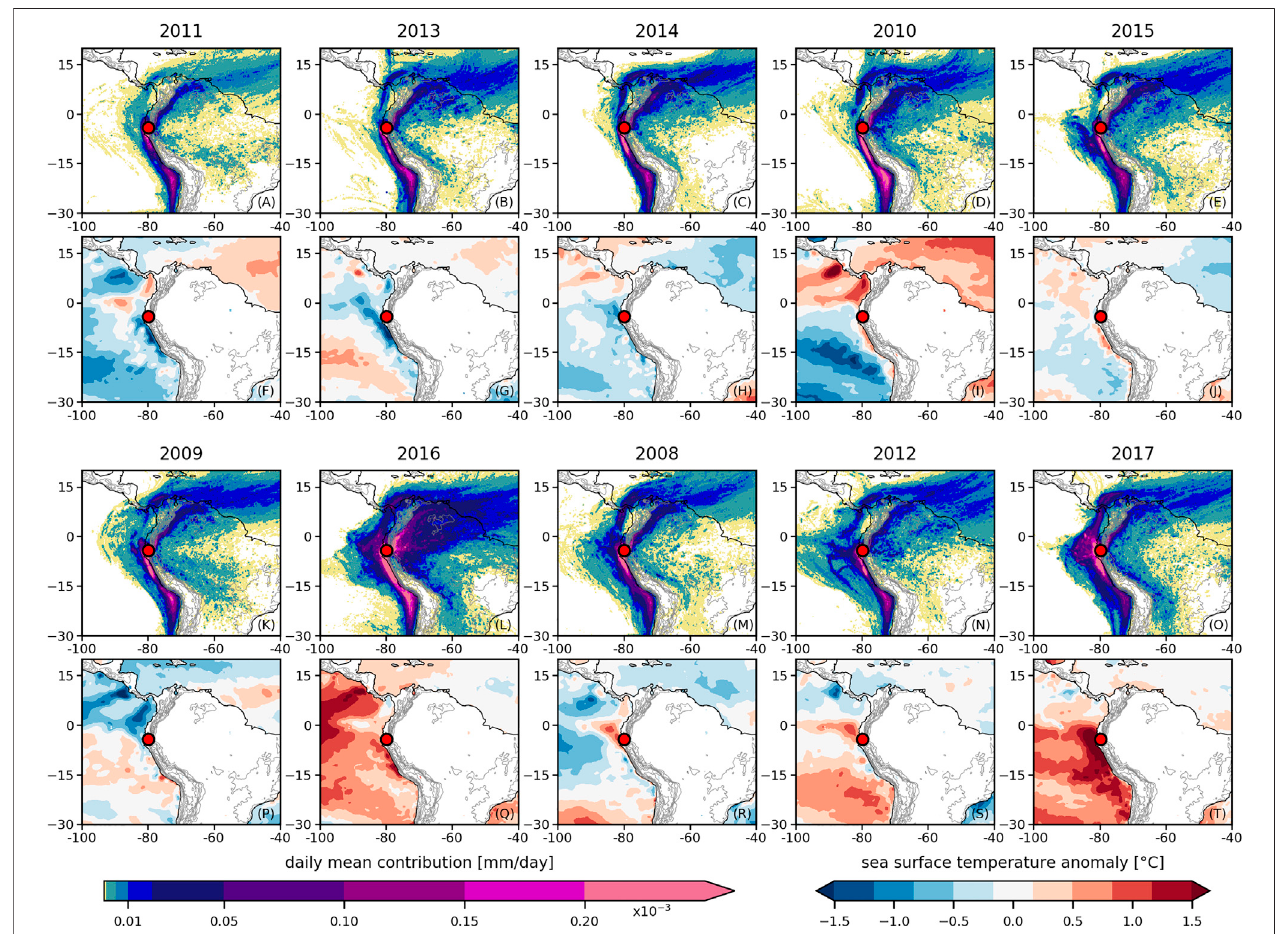
FIGURE8| Moisture sourceregionsgivenasdailymeancontribution(mm/day) totheprecipitationat thestudysiteforallcalculatedpressurelevelsand separated intothecompositesofeachyear(2008 – 2017) (A – E,K – O) .Therainyseasonprecipitation sumsincreasefromtheupperleftplottothelowerrightone.Everysecondrow showsseasurfacetemperatureanomalies (F – J,P – T) withrespecttothetimeperiodfrom2008to2017.Topographiccontours,with750 minterval,shownasgraylines.